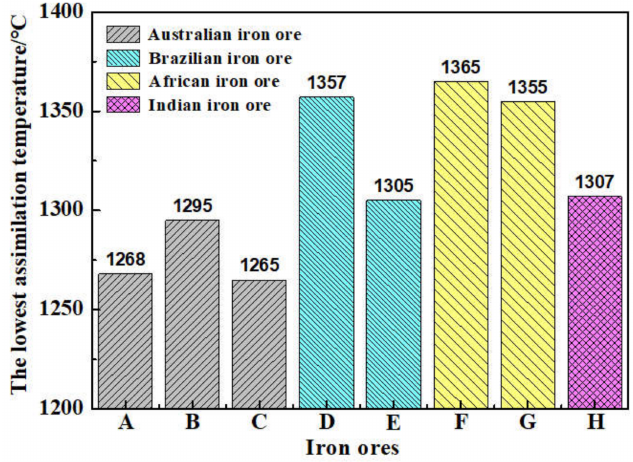
Figure 4. Assimilability of iron ores in various alumina types.